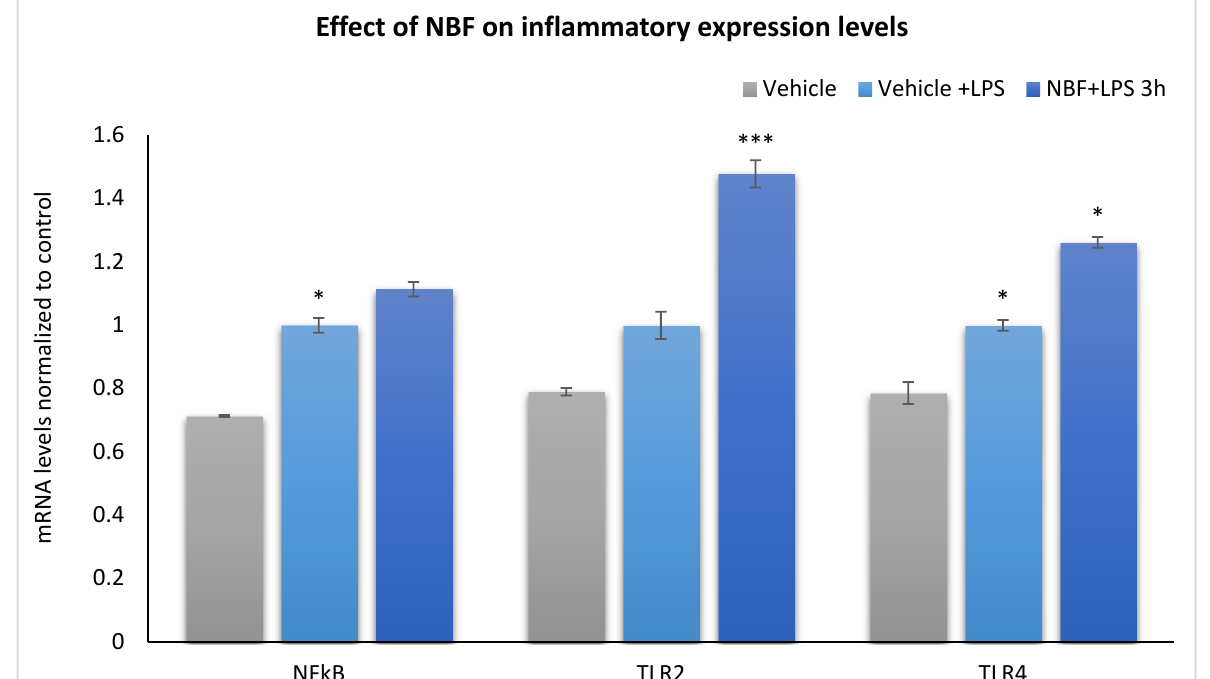
Figure 6. NBF upregulates mRNA expression levels of TLR2 and TLR4 but not NF- κ B . RAW264.7 cells were treated with either Vehicle + LPS or NBF + LPS for 3 h. mRNA was extracted 3 h after treatment using an mRNA extraction kit and NF- κ B, TLR2, and TLR4 mRNA were quantified and normalized to the glyceraldehyde 3-phosphate dehydrogenase (GAPDH)—mRNA expression levels are shown as the fold differences compared to untreated cells. Data are represented as the mean ± SEM of three independent experiments (three separate experiments in triplicates) and statistical analyses were performed using ANOVA followed by Bonferroni’s post hoc test. * p < 0.05, *** p < 0.001 vs. vehicle.